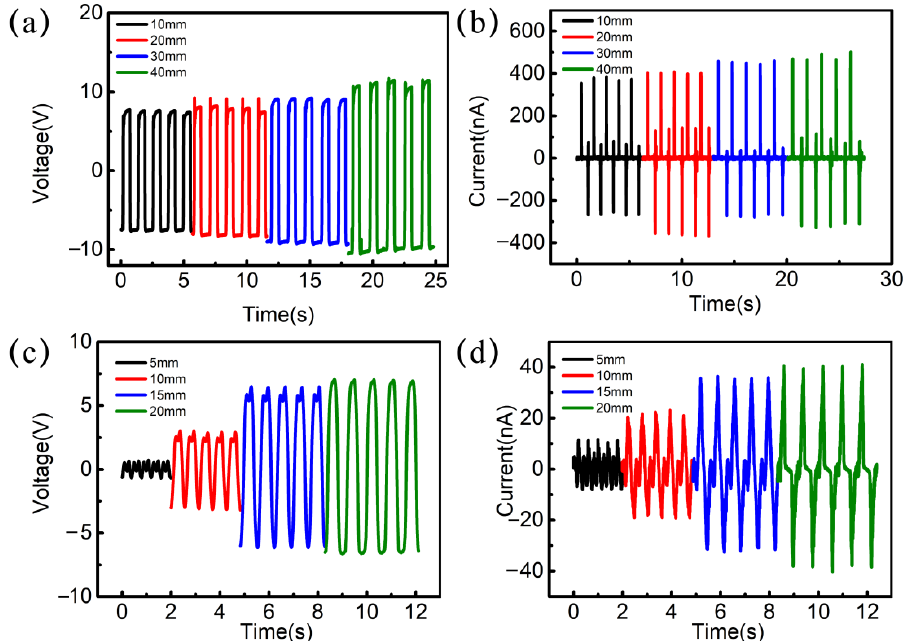
Figure 3. Output performance of the TENG. ( a ) Open-circuit voltage and ( b ) short-circuit current with a cyclic contact force of different amplitudes based on contact mode. ( c ) Open-circuit voltage and ( d ) short-circuit current of the TENG based on lateral sliding mode.